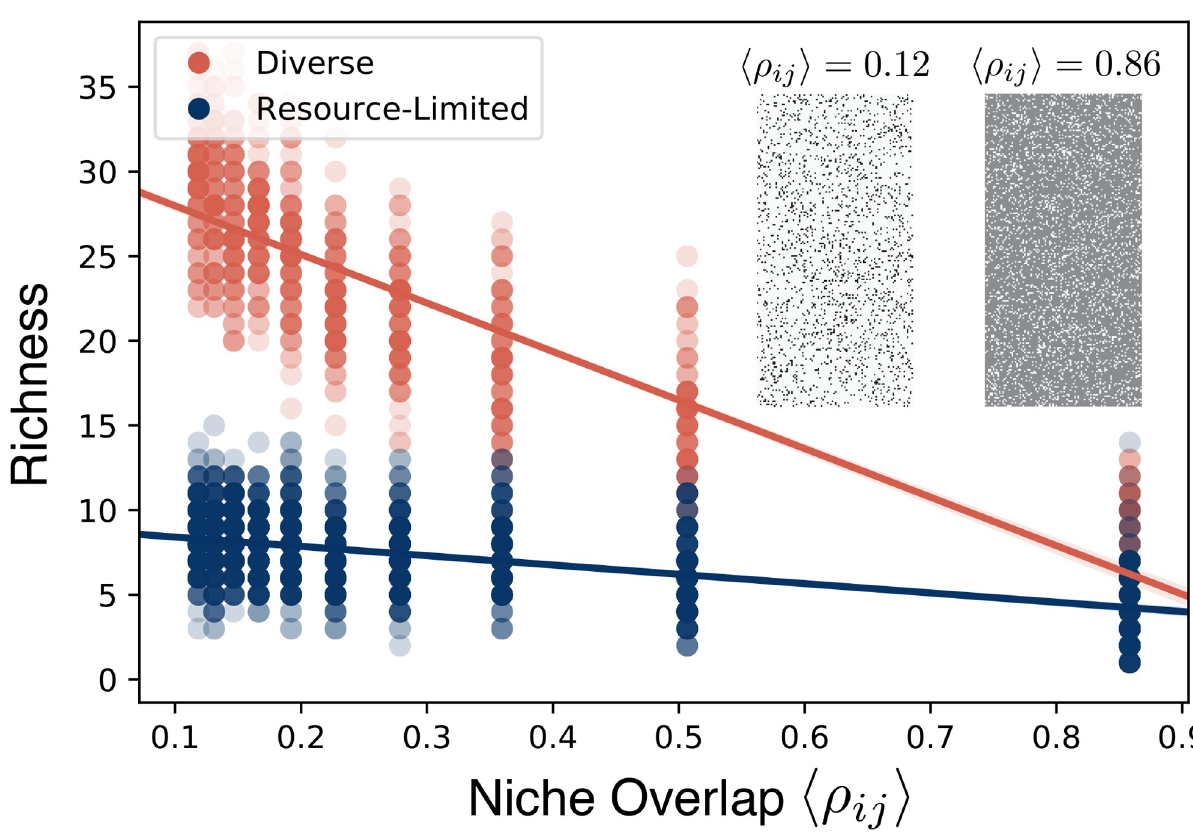
Fig 5. Richness of diverse regime depends on generalized niche-overlap. We took the values of supplied energy flux w 0 κ 0 and leakage fraction l from the three examples highlighted in Fig 2, and varied the average niche overlap h ρ i between members of the metacommunity. For each w 0 κ 0 , l ij combination and each value of h ρ ij i , we generated 10 pools of 200 species, initialized 10 communities of 100 species each from this pool, and ran the dynamics to steady state. The steady-state richness of each community is plotted against the niche overlap. Points are colored by their regime (diverse or resource-limited), and solid lines are linear regressions. Inset: c matrices that define the regional pool for two different levels of overlap, with dark i α squares representing high consumption